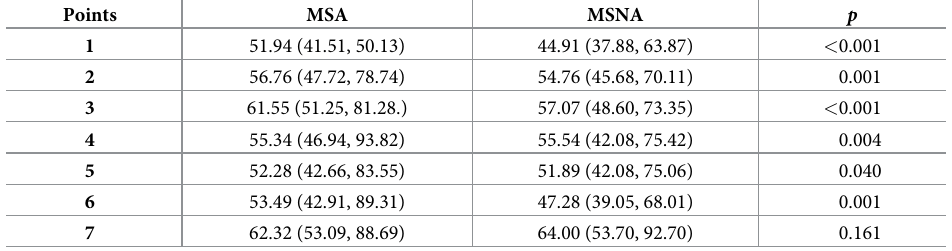
� Values presented in median (first quartile, third quartile). MSA: Affected upper limb by lymphedema. MSNA: Unaffected upper limb by lymphedema.